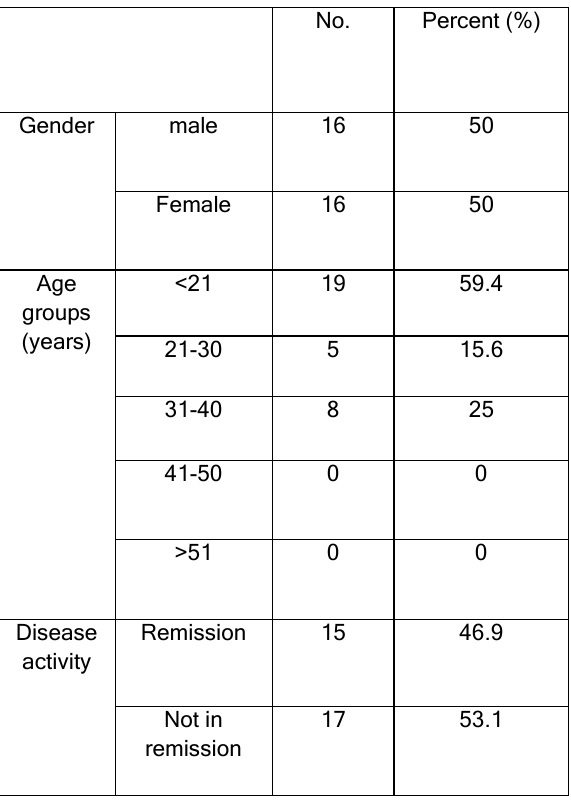
Table-. 1- patients